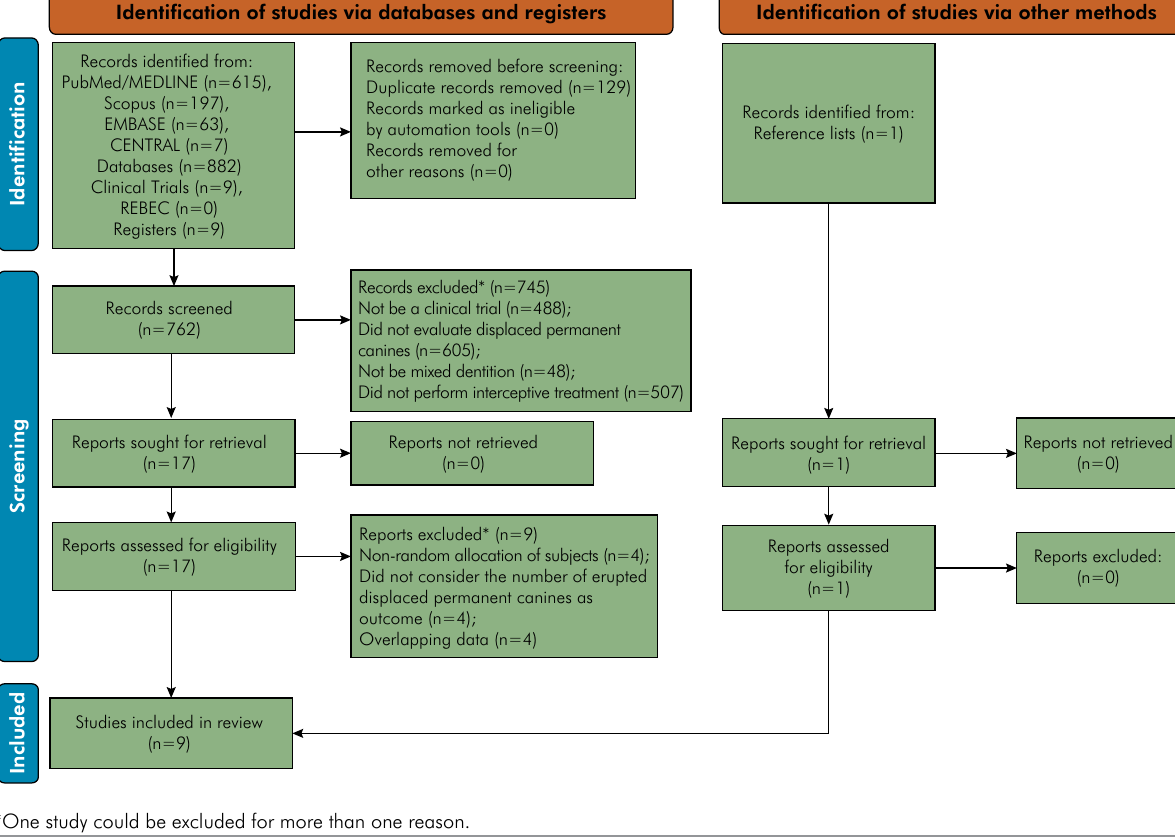
Figure 1. Flow diagram of the study selection according to the PRISMA